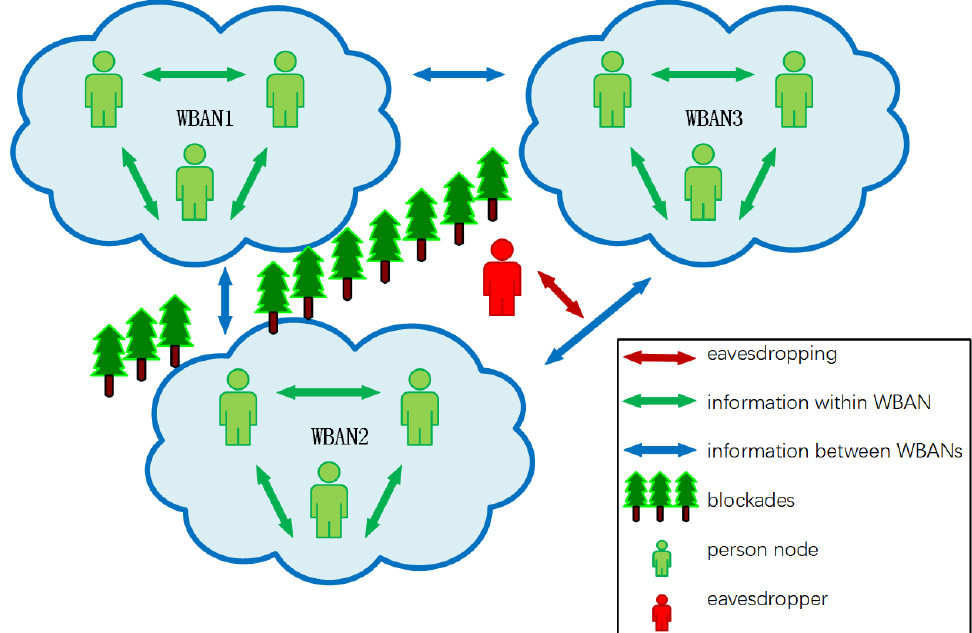
Figure 1. The network structure of a BBN. Each WBAN consists of a number of person nodes with sensors on or in their bodies. Three WBANs form a BBN and could interact with one